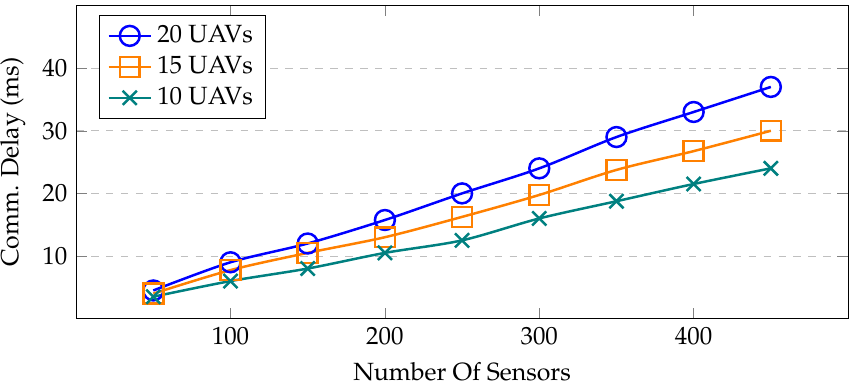
Figure 10. Average UAV-to-UAV communication delay with different numbers of sensors and